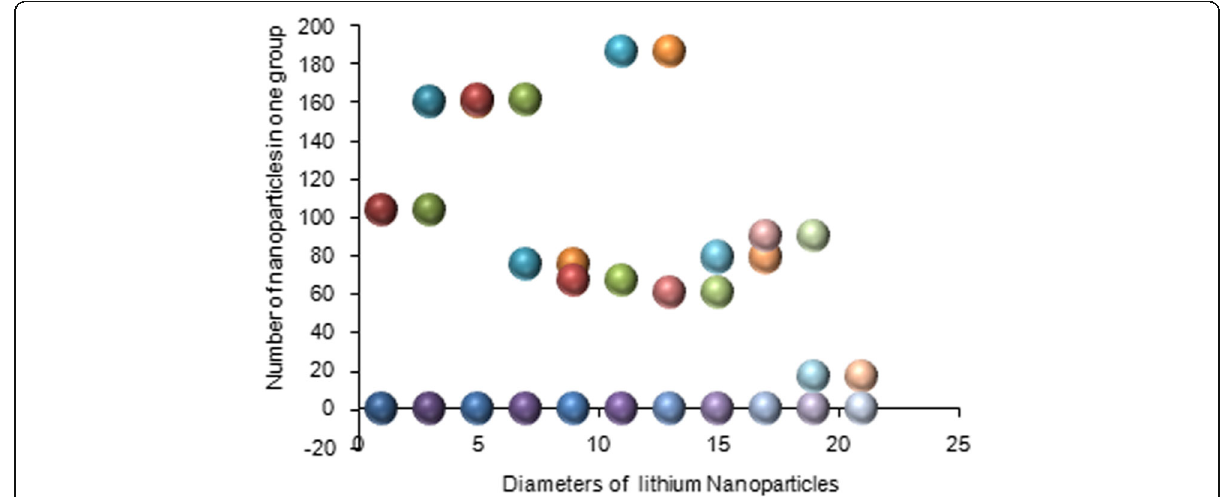
Fig. 8 Group of nanoparticles in the lithium cells and their number in one of the proposed